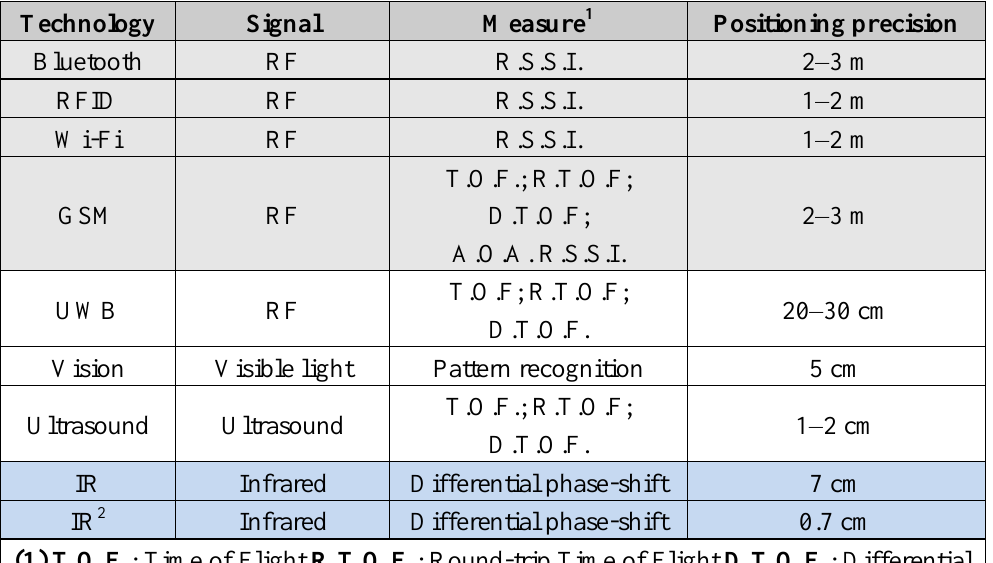
Table 4. Comparison of indoor local positioning